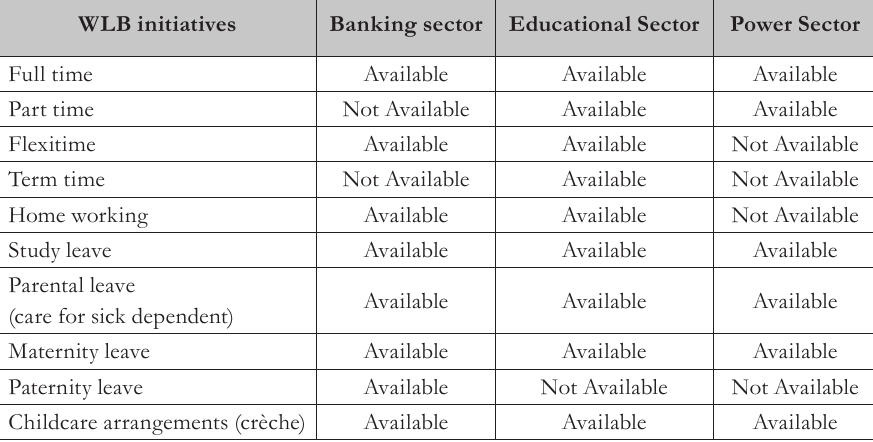
Tab. 2 - WLB initiatives. Source: Field Survey,